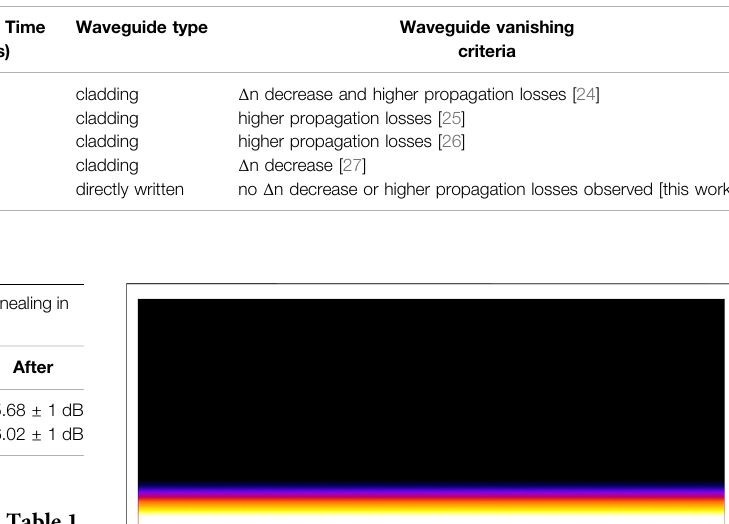
Figure 8B . In both fi gures, 0 ° and 90 ° correspond to TE and TM polarized incident light, respectively.